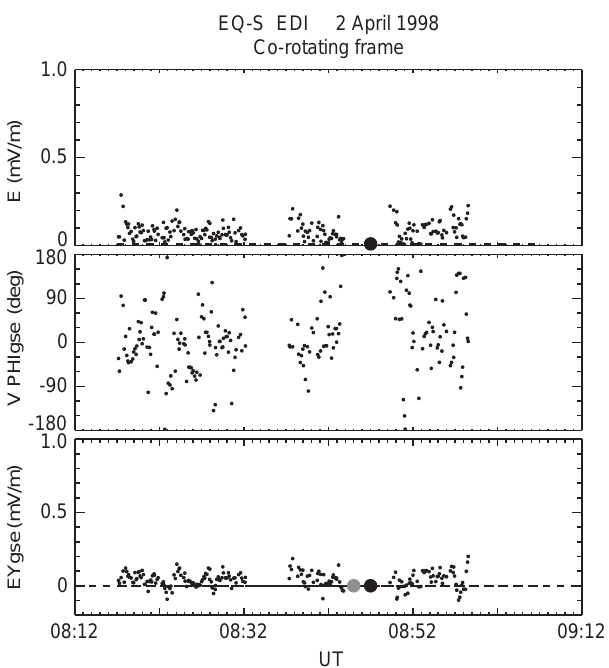
Fig. 7. April 2, 1998 measurements in the co-rotating frame. Same format as Fig. 5. Missing data (08:32–08:37 and 08:44–08:49) are gaps in EDI triangulation telemetry during diagnostic testing